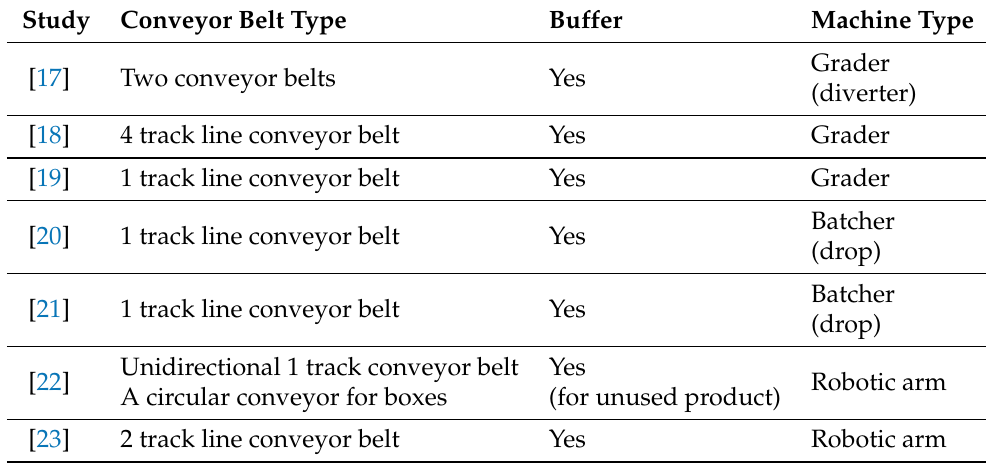
Table 2. Related work for a robotic arm-based batching system